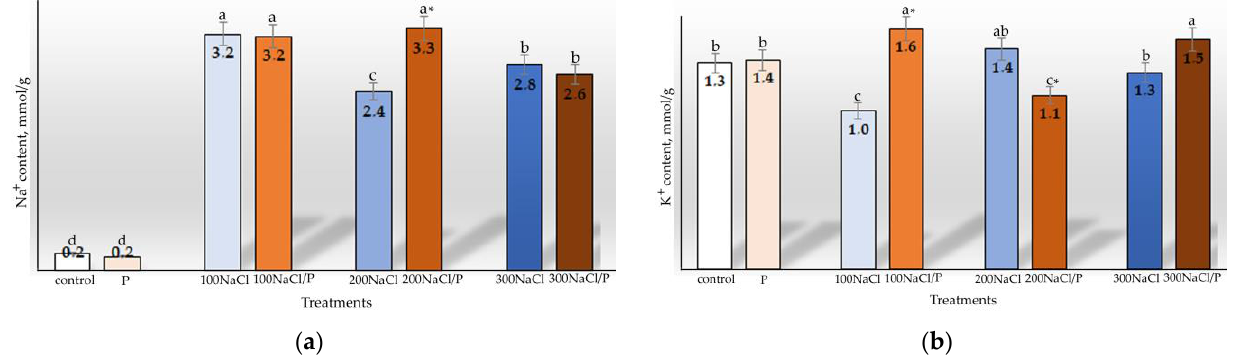
Figure 3. Dependence of ion content in leaves of young Chenopodium quinoa on stress conditions: ( a ) sodium ions; ( b ) potassium ions. The values shown are means (± SD). Different letters above the bars indicate a significant difference within the chart (between different stress intensities), whereas * indicates a significant difference between the single component and the combined stress at p ≤ 0.05.